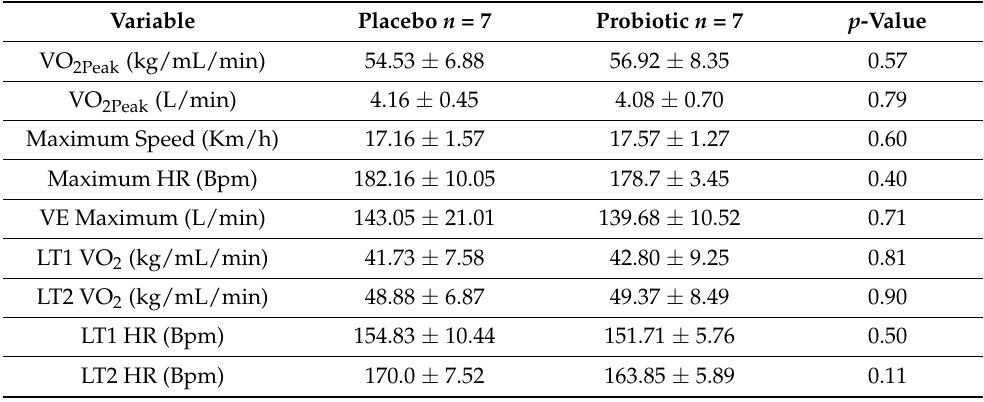
Table 3. Ergospirometry data.